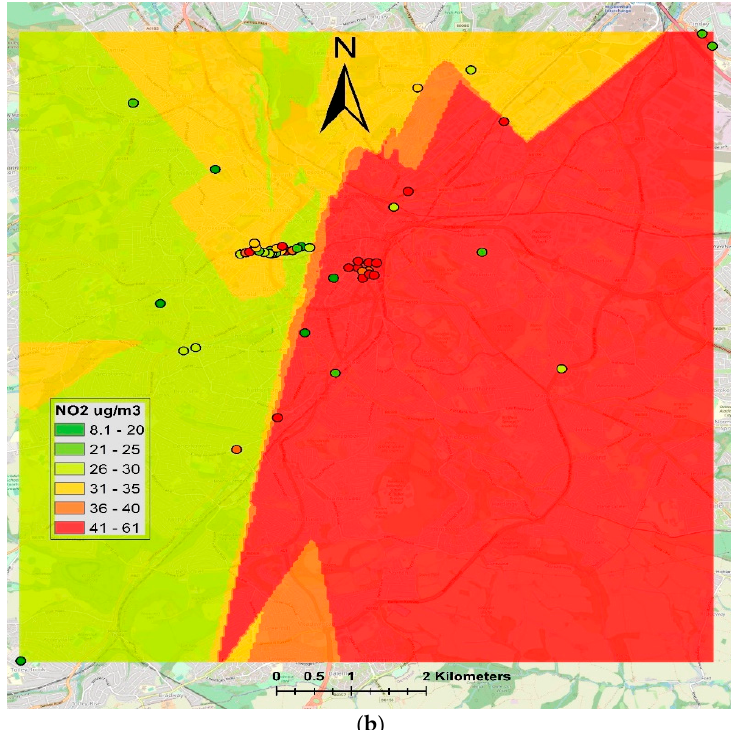
Figure 5. Showing point and interpolated NO 2 levels from LCS network: ( a ) NO 2 concentrations